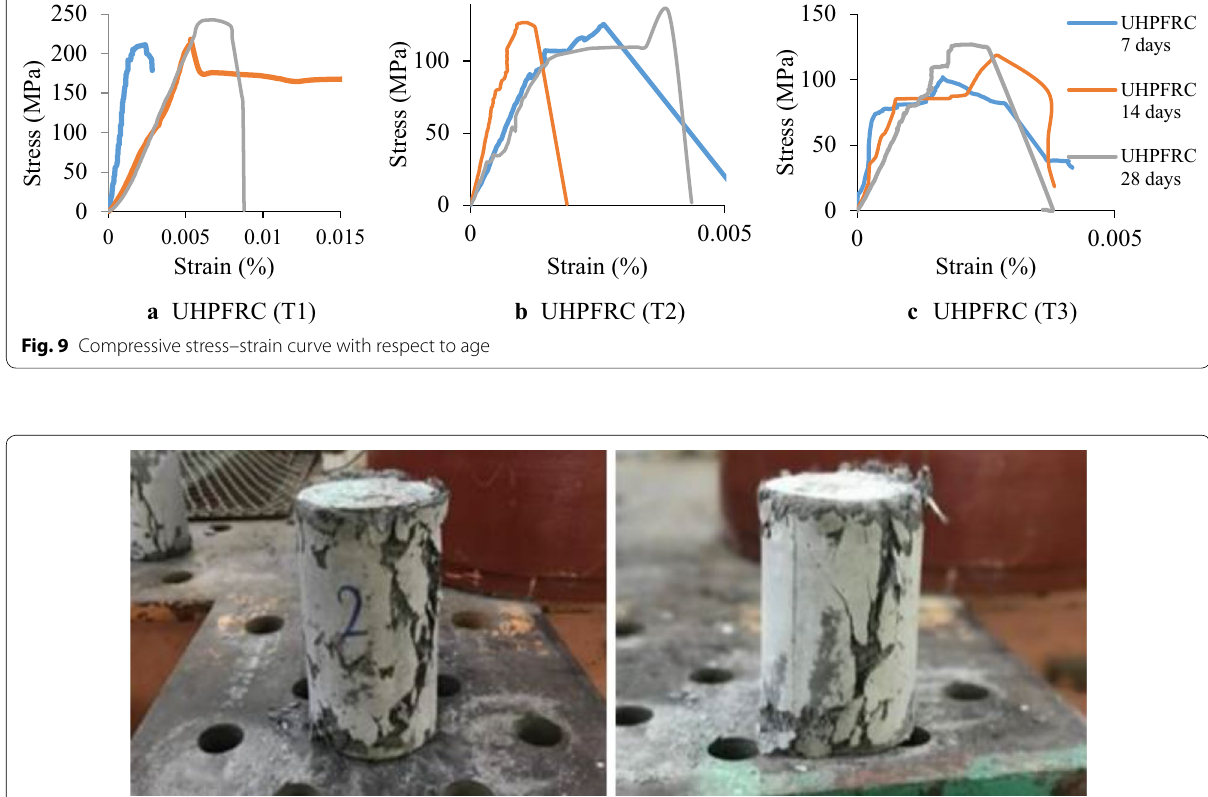
Fig. 10 Compression tests: formation of cracks and UHPFRC (T1) at